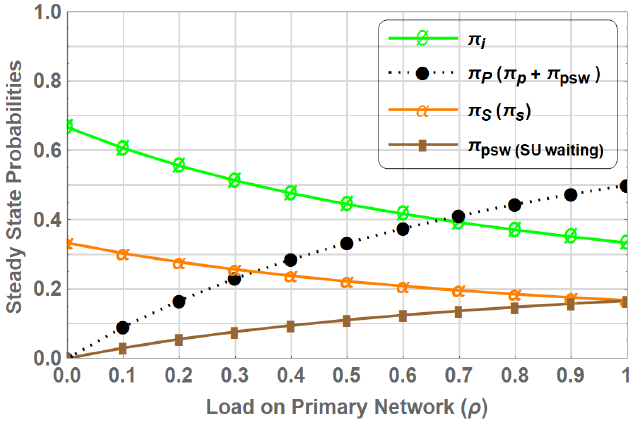
Figure 6. Stationary probabilities for